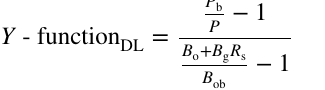
Fig. 21 Different Y-function of reservoir S—CCE test